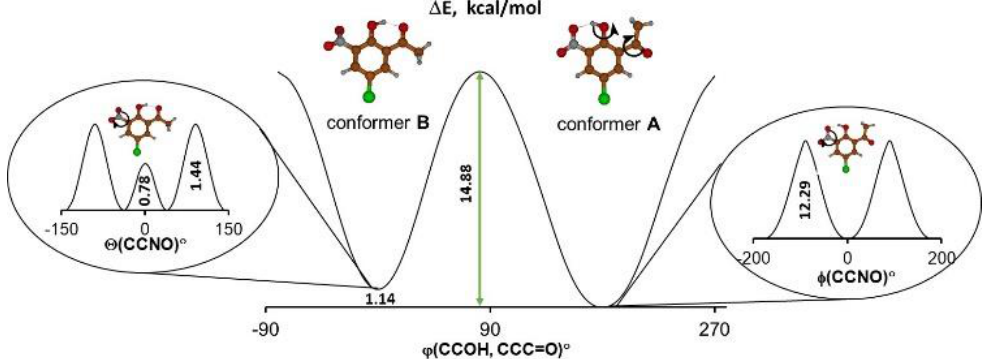
Figure 1. The calculated (B3LYP/6-311++G(2d,2p)) potential energy curves for the intramolecular hydrogen bond transformation (picture in the centre) and the nitro group rotation (picture in the left related to conformer B and picture in the right related to conformer A).